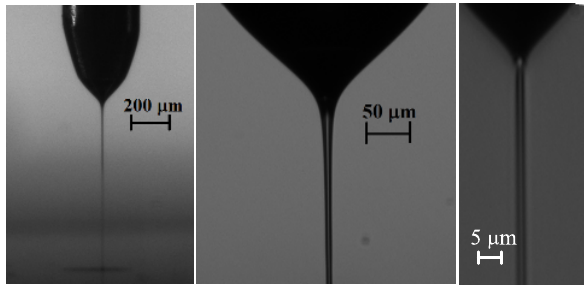
Fig. 3. 1-octanol jet (left and center) produced a standard capil- lary ( Q = 500 (cid:22) l / h and V = 1 : 6 kV). The left (center) image was acquired with the auxiliary (working) CCD camera. 1-propanol jet (right) produced with a hypodermic needle ( Q = 40 (cid:22) l / h and V = 1 : 3